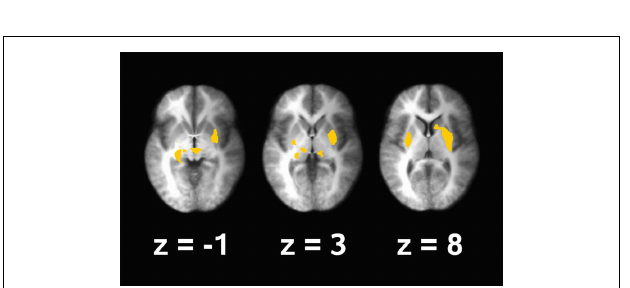
FIGURE 4 | Subcortical functional ROI (fROI). Four subcortical fROI were identified by conjoining the activation maps from the voxel-wise analyses. In all of the fROI, activation was greater in the unimodal than the crossmodal timing condition. No other effects were significant. z coordinates are the superior ( + )/inferior ( − ) distance in millimeter from the anterior commissure.